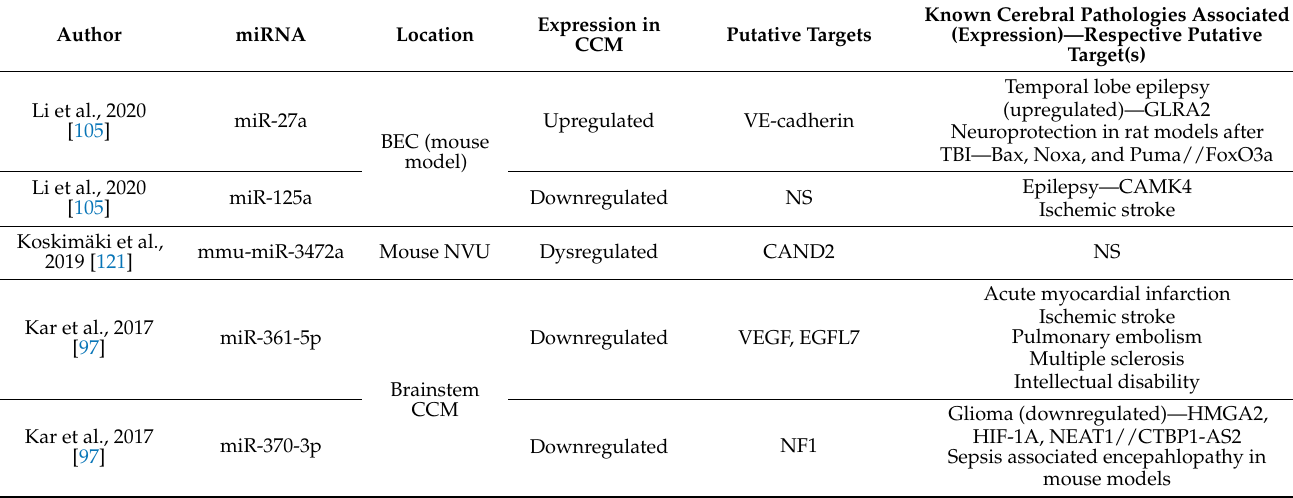
Table 2. Location, Expression and Putative Targets of Identified microRNAs in Cerebral Cavernous Malformations. Author